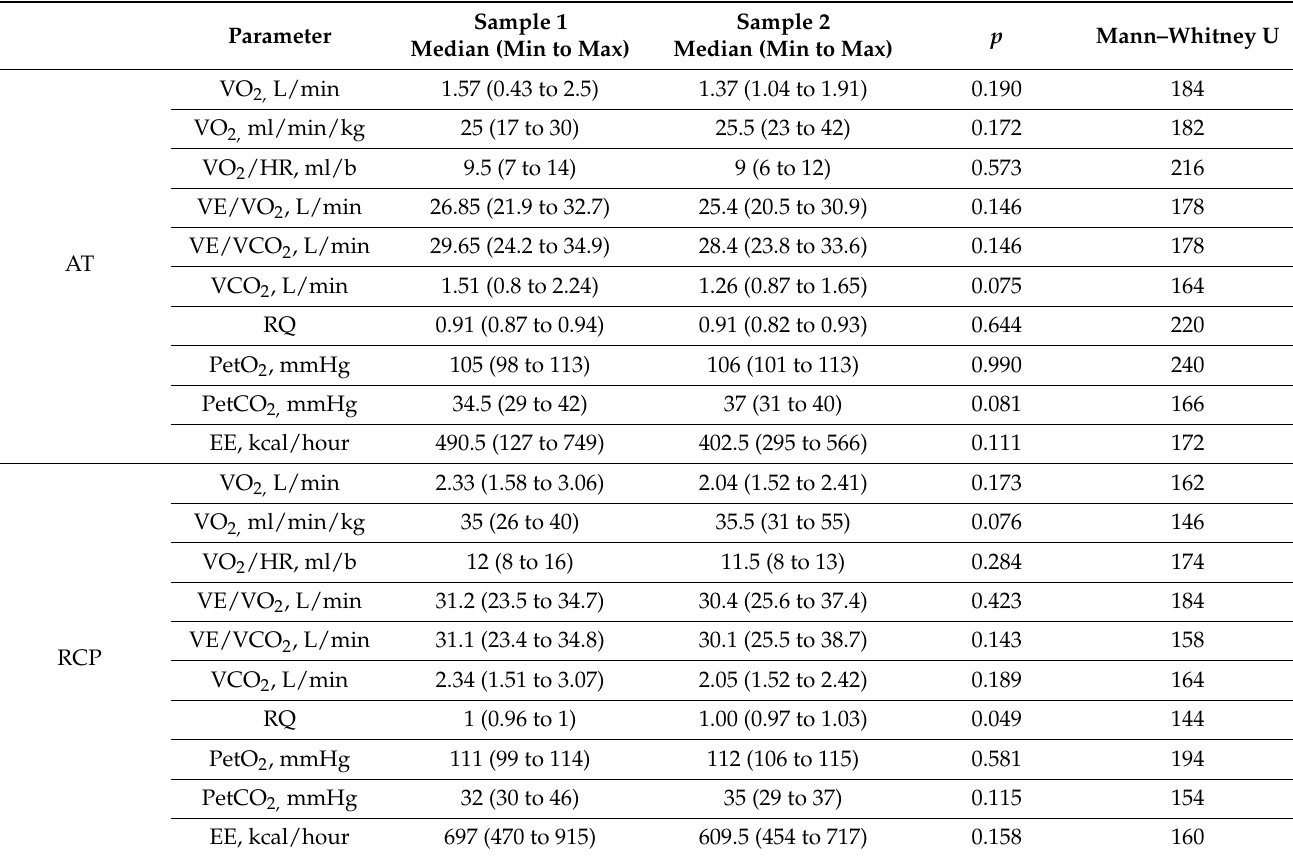
Table 3. A Comparative analysis regarding AT and RCP data in Sample 1 and Sample